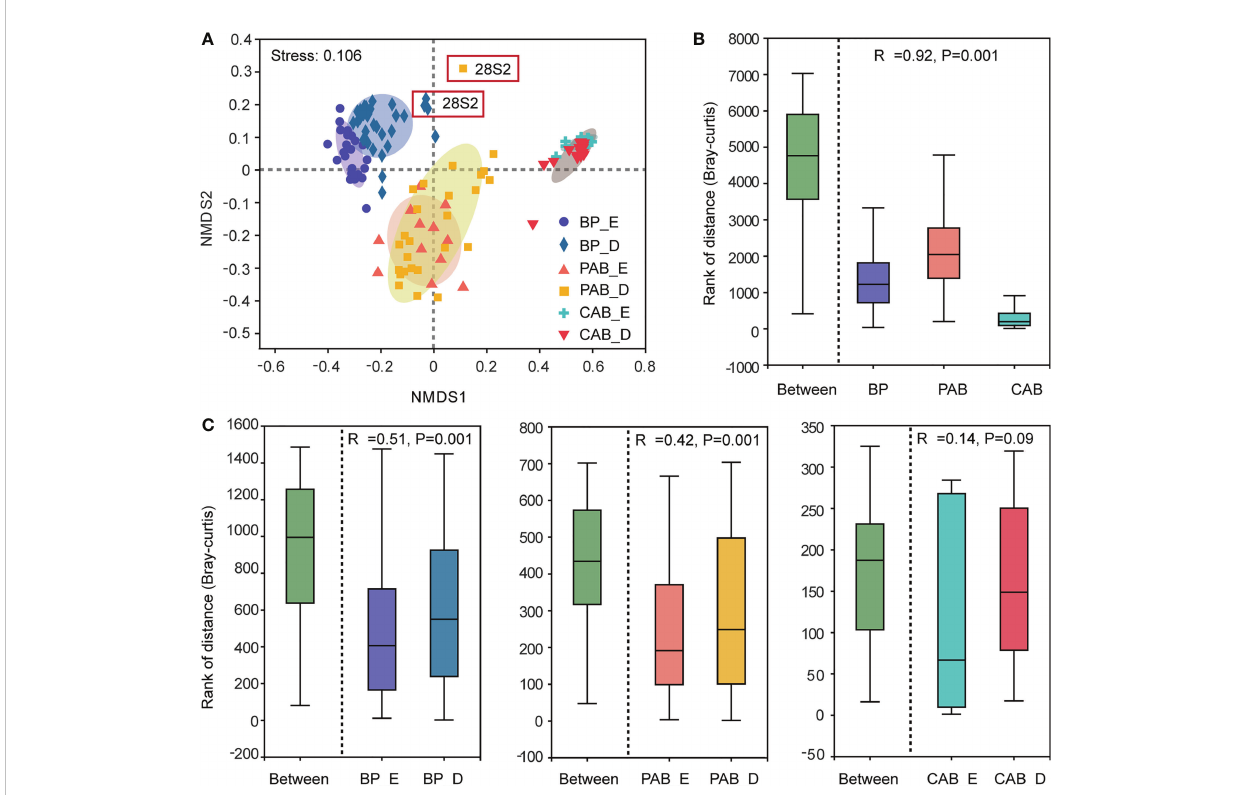
FIGURE 5 NMDS on genus level (A) , distances boxplot among three kinds of bacteria (B) and between exponential and decline growth phase of Phaeocystis globosa bloom (C) . BP, bacterioplankton; PAB, particle-attached bacteria; CAB, colony-attached bacteria; E, exponential growth phase of bloom; D, decline growth phase of bloom.